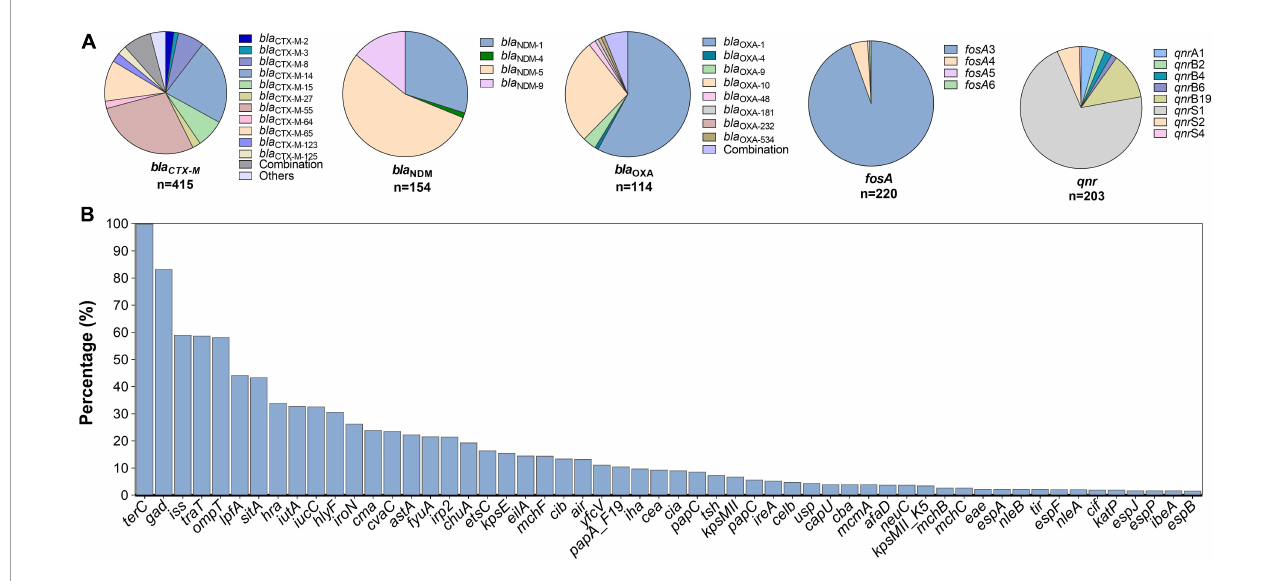
FIGURE4 Subtypes of antimicrobial resistance genes (A) and prevalence of common virulent factors (B) among mcr-positive Escherichia coli .